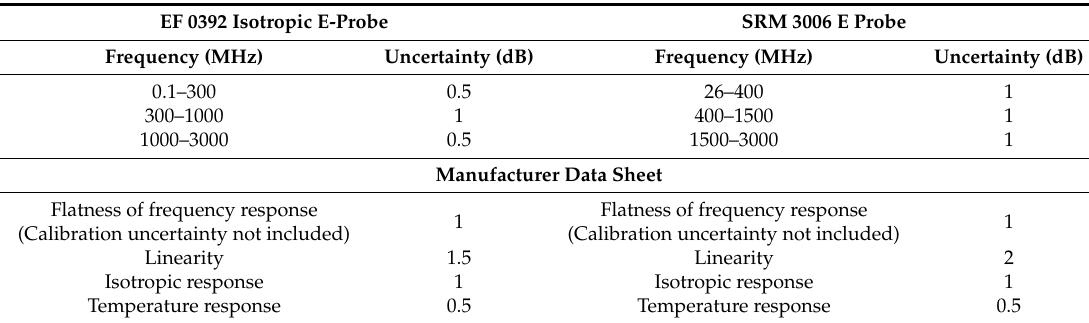
Table 2. Uncertainties of probes and